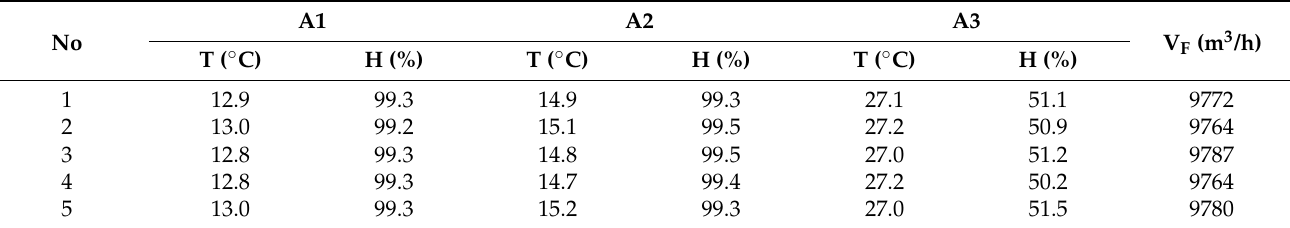
Table 19. Air side measurement result (five